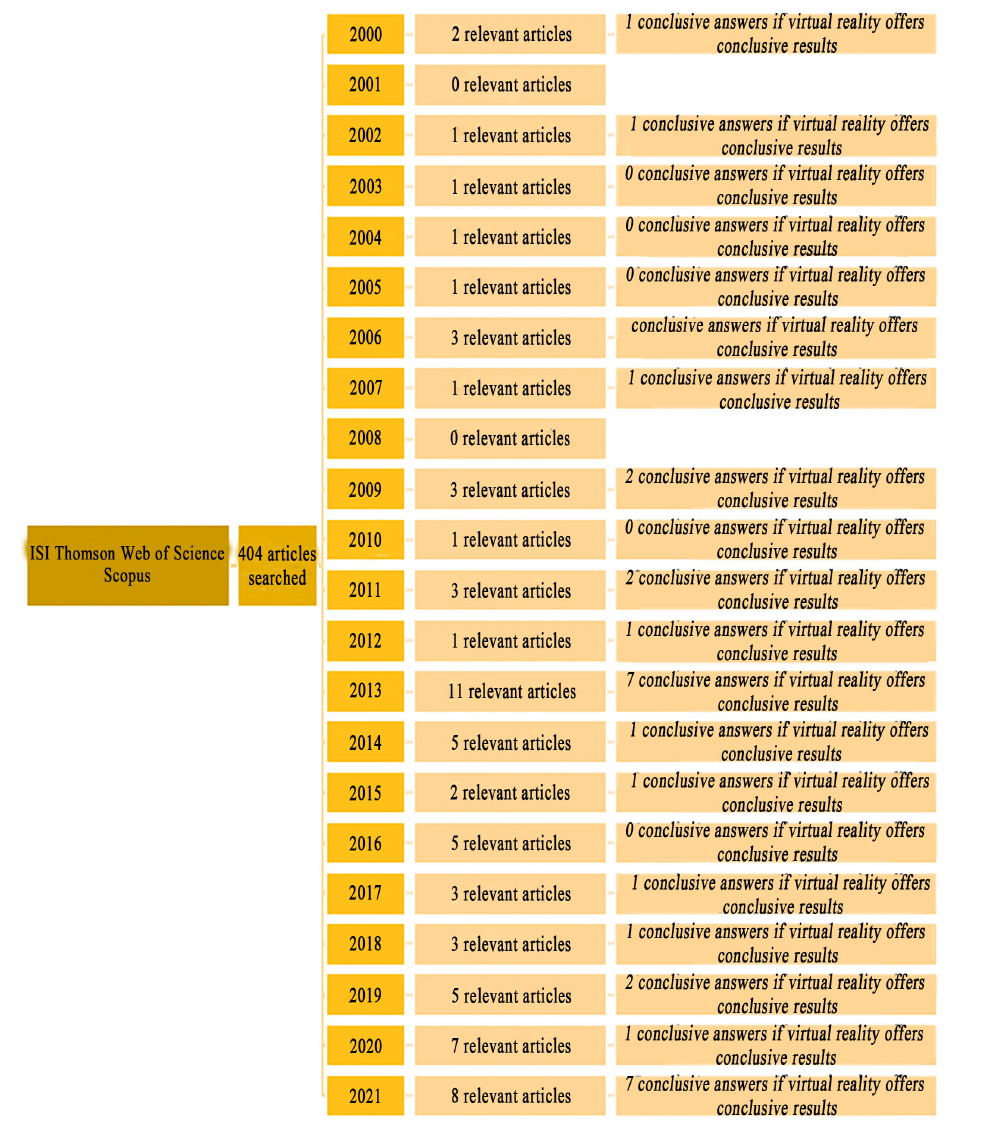
Fig. 2. Annual presentation of relevant study articles as well as the number of articles that provide accurate information on the benefits of using virtual reality in re-educating patients with spinal cord